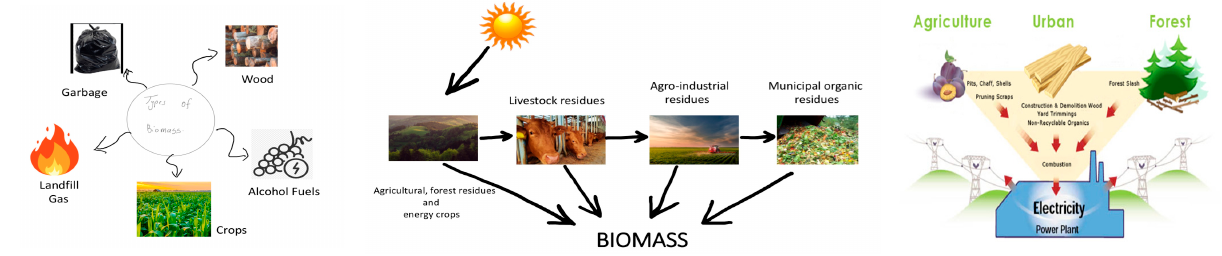
Figure 25. Solar energy-based processes for biomass production [60].